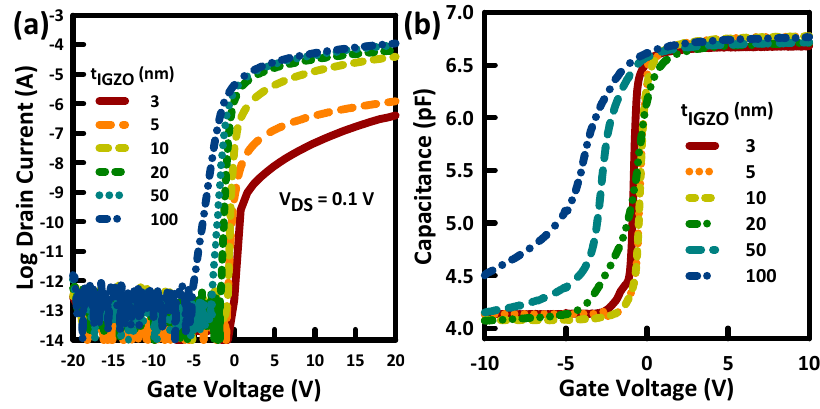
Figure 4. Amorphous indium-gallium zinc-oxide (a-IGZO) thin-film transistor characteristics as a function of a-IGZO thickness ( t IGZO ), ( a ) current-voltage ( I - V ) and ( b ) capacitance-voltage ( C - V ) characteristics. Table 1. Key thin-film transistor parameters.